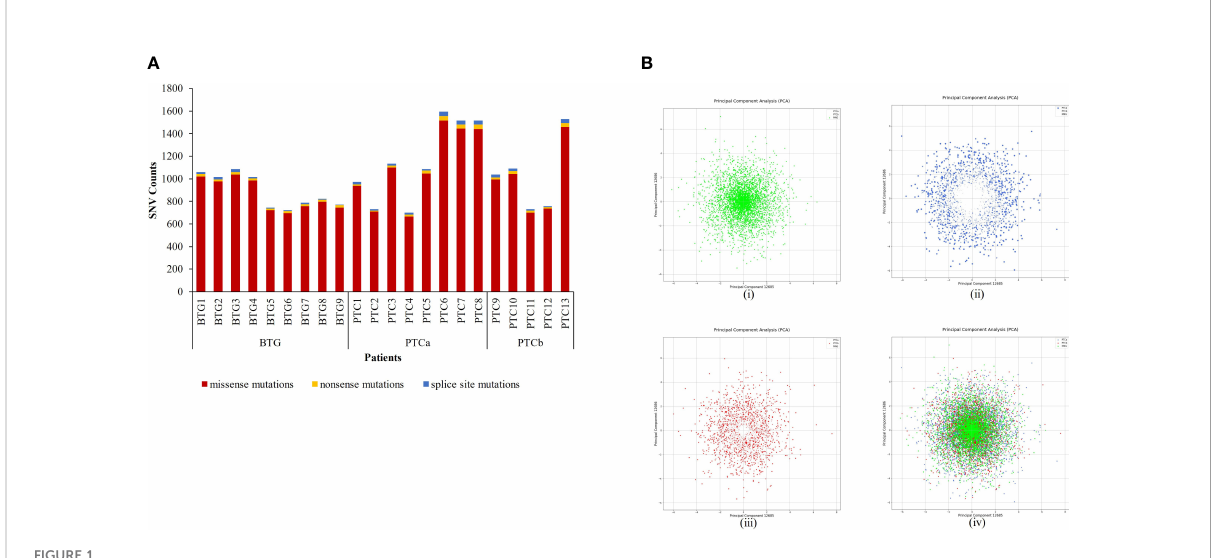
FIGURE 1 Analysis of nonsynonymous and splice-site single nucleotide variants (SNVs) identi fi ed through whole exome sequencing in patients with benign thyroid goitre (BTG), papillary thyroid cancer without BTG background (PTCa) and with BTG background (PTCb). (A) Nonsynonymous SNVs identi fi ed in each patient were fi ltered against 1000 Genome Projects (MAF ≤ 0.01). (B) Principal Component Analysis (PCA) of SNV pro fi les (gene, mutation, and genotype status) of the fi ltered nonsynonymous SNVs in (i) BTG, (ii) PTCa in relation to BTG, (iii) PTCb in relation to BTG and (iv) all disease